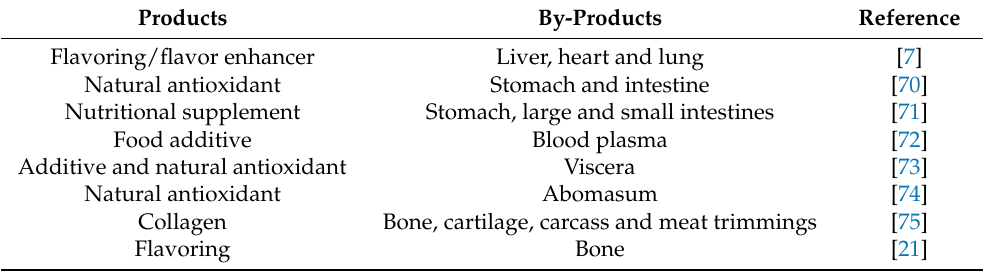
Table 4. Hydrolyzed proteins from slaughter by-products of goats and sheep. Products By-Products Reference Flavoring/flavor enhancer Liver, heart and lung [7] Natural antioxidant Stomach and intestine Nutritional